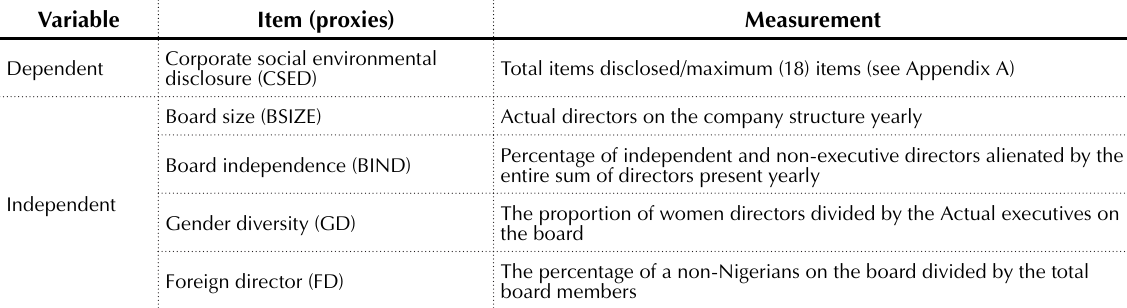
Table 1. Measurement